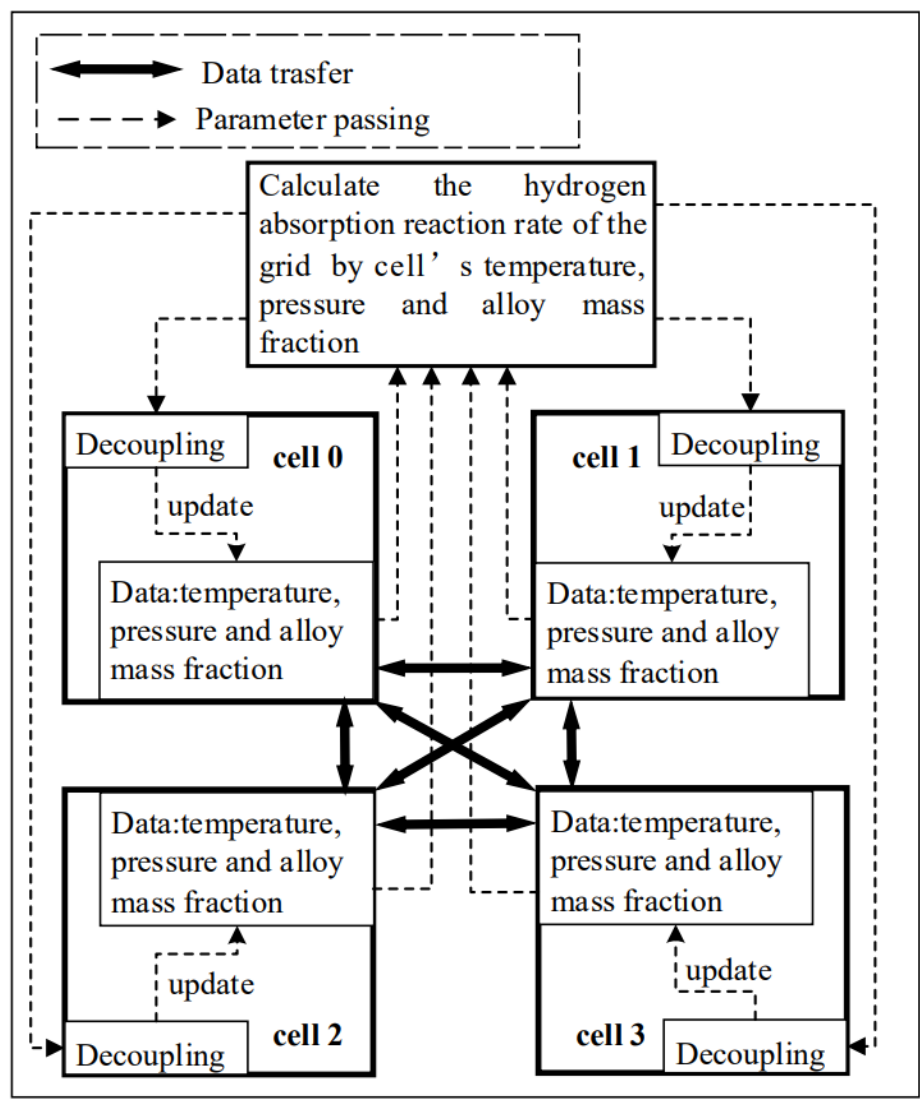
Figure 2. A calculation principle diagram.